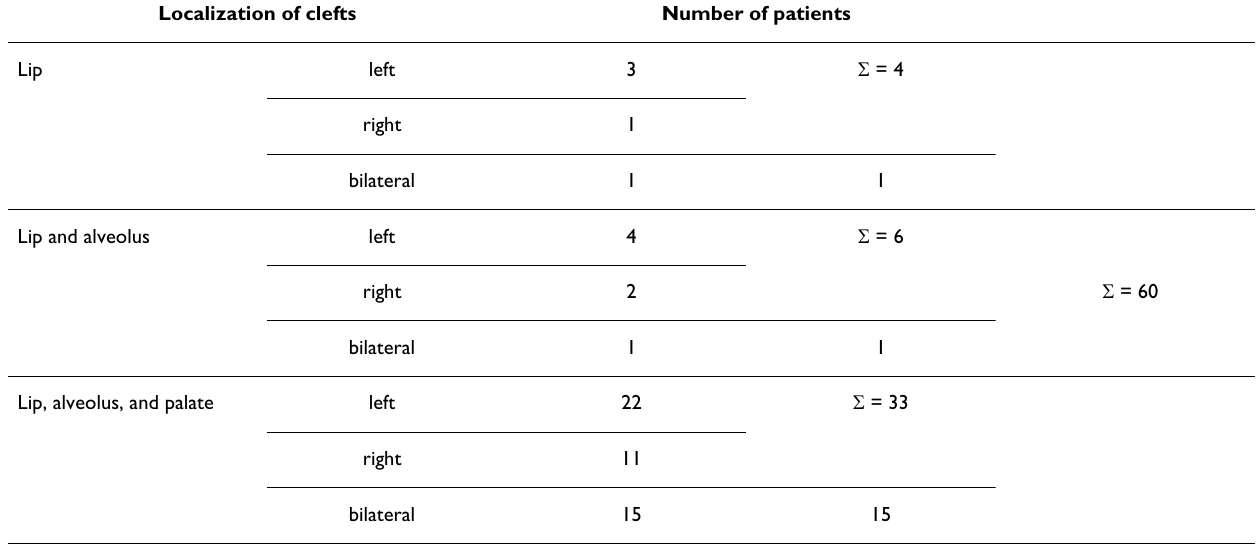
Table 1: Localization of clefts in the patient group. Localization of